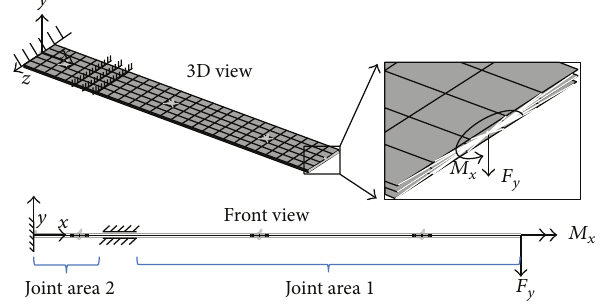
Figure 13: Multilayer sheet